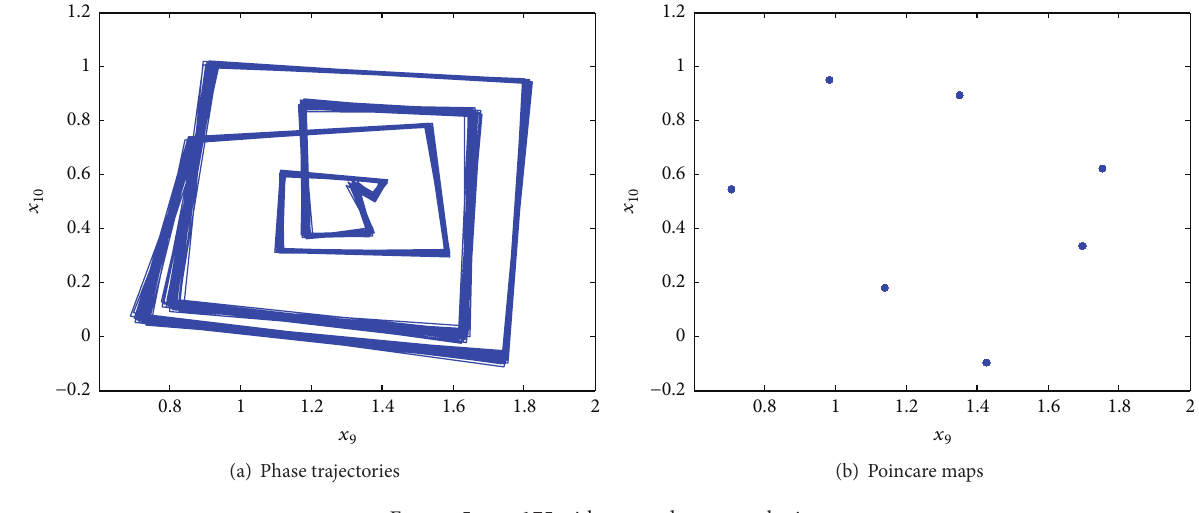
Figure 5: 𝜔 = 175 without random perturbation.